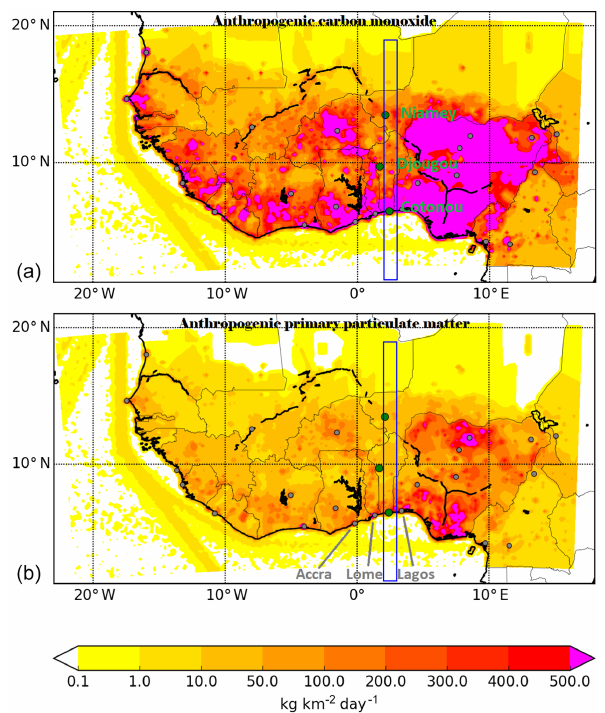
Figure 1. Anthropogenic carbon monoxide (a) and primary particu- late matter (b) surface emission fluxes in kgkm − 2 day − 1 averaged over the 3-month period. The gray dots are the major cities and the three green dots are the locations studied from the south to the north: Cotonou (Benin), Djougou (Benin), Niamey (Niger). The blue box represents the Cotonou (Benin)–Niamey (Niger) meridional tran- sect studied (longitude λ = 2 ◦ to 3 ◦ E, latitude φ = 1 to 19 ◦